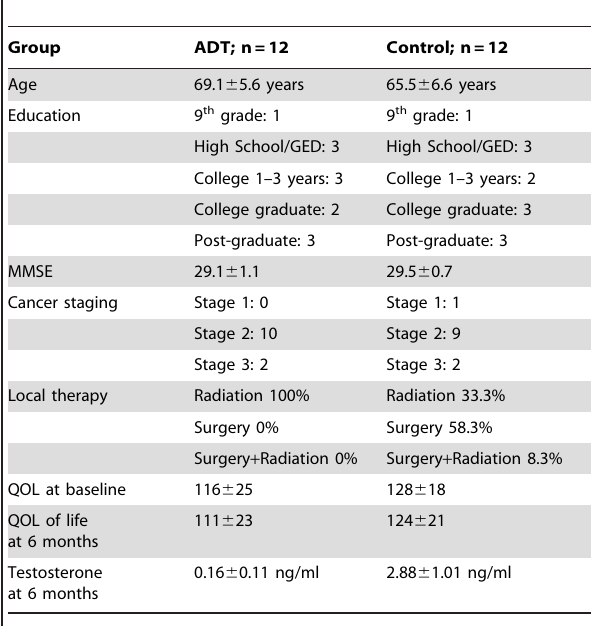
Table 1. Patient characteristics and quality of life